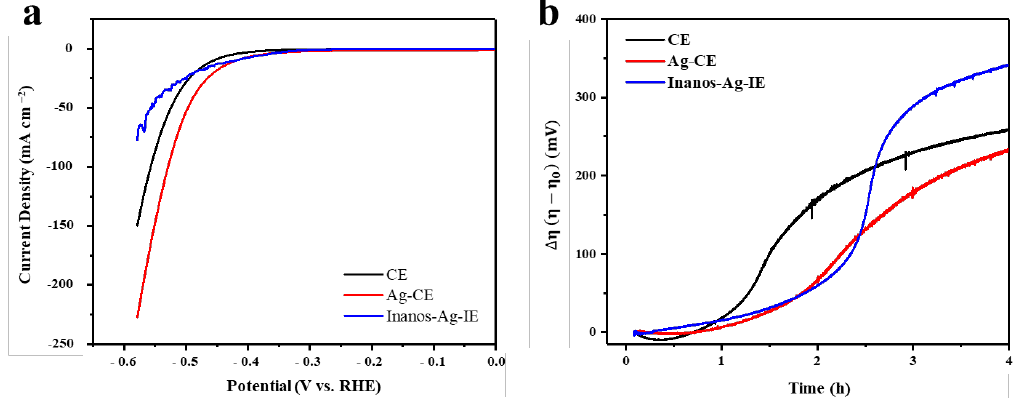
Figure 3. Electrochemical catalytic activity for HER: ( a ) Polarization curves and ( b ) Stability test for CE, Ag-CE, and Inano-Ag-IE.